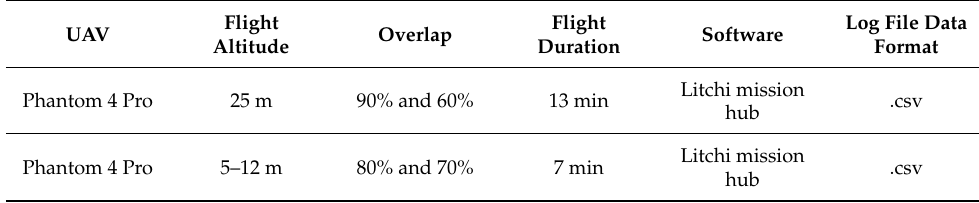
Table 3. Flight details for Lesvos Petrified Forest dataset.